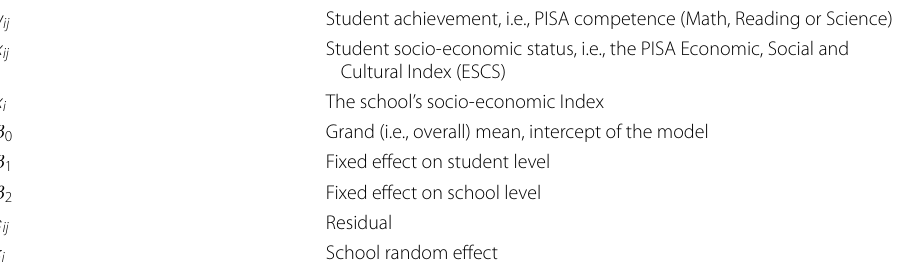
Table 1 Variable definitions for hierarchical models used in this paper y ij Student achievement, i.e., PISA competence (Math, Reading or Science) x ij Student socio-economic status, i.e., the PISA Economic, Social and Cultural Index (ESCS) x i The school’s socio-economic Index β 0 Grand (i.e., overall) mean, intercept of the model β 1 Fixed effect on student level β 2 ε ij Residual τ